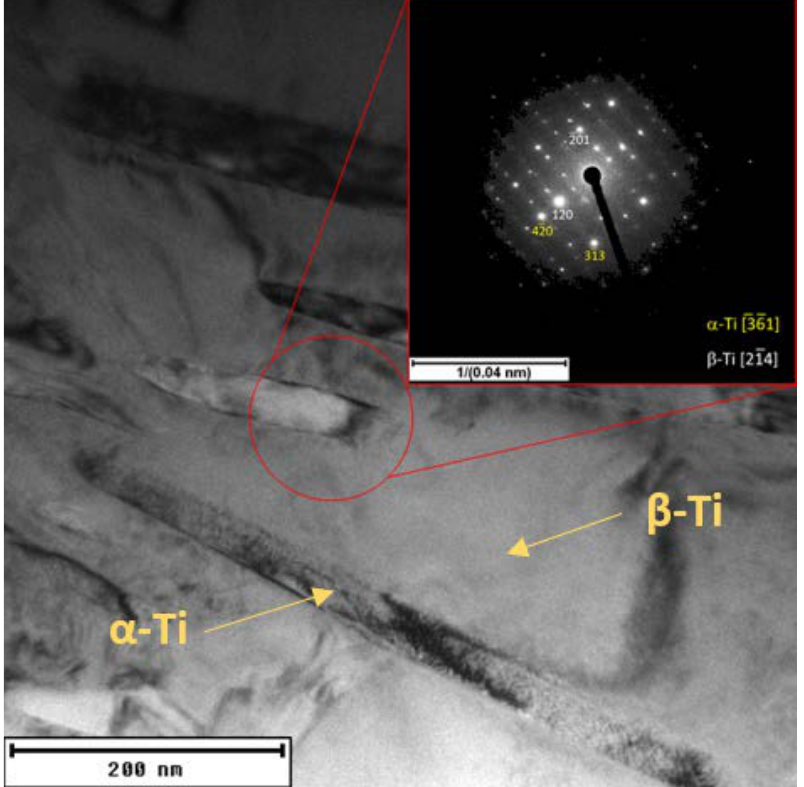
Figure 8. Detailed microstructure of SPS_HT sample with needle-like α -Ti phase in β -Ti matrix (TEM).